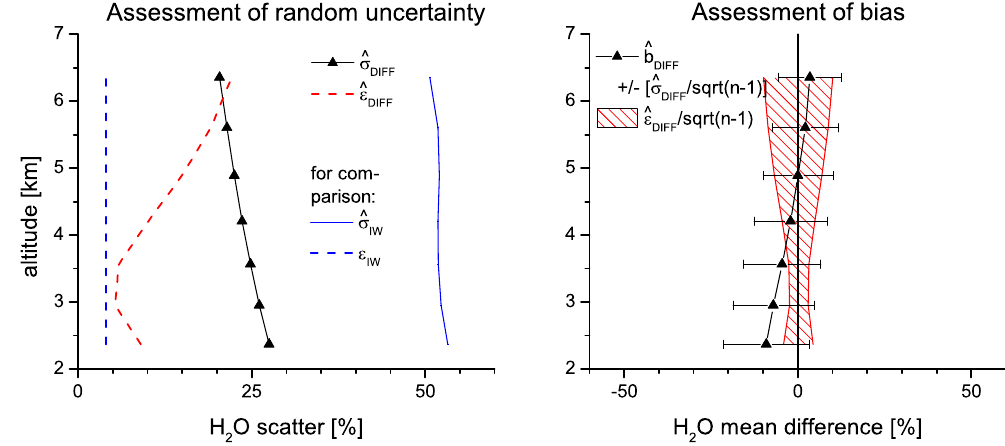
Figure 7. Left graph, assessment of the random uncertainty. Black symbols: the FTIR-ISOWAT scatter ( ˆ σ DIFF value according to Eq. 4). Red dashed line: the predicted scatter ( ˆ (cid:15) DIFF value according to Eq. 5). Blue solid line: the scatter in the convolved ISOWAT data ( ˆ σ IW value according to Eq. 6). Blue dashed line: the uncertainty in the not convolved ISOWAT data ( (cid:15) IW ). Right graph, assessment of the bias. Black symbols and error bars: the FTIR-ISOWAT mean difference and standard error of the mean ( ˆ b DIFF and ˆ σ DIFF / Eqs. (3) and (4), respectively). Red area: the predicted uncertainty range (calculated as ˆ (cid:15) DIFF /